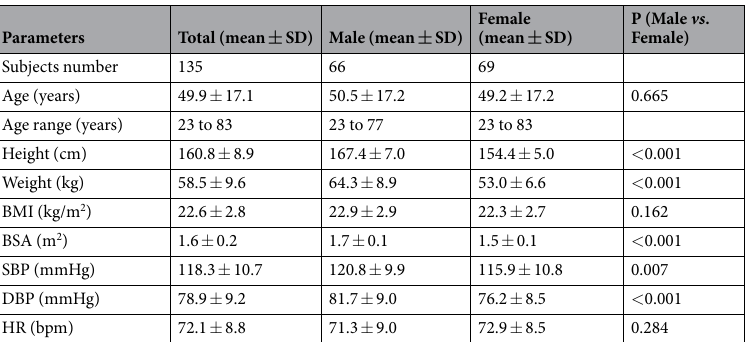
Table 1. Demographic characteristics. BMI, body mass index, calculated by (weight in kg)/(height in m) 2 ; BSA, body surface area, calculated by DuBois & DuBois formula; SBP, systolic blood pressure; DBP, diastolic blood pressure; HR, heart